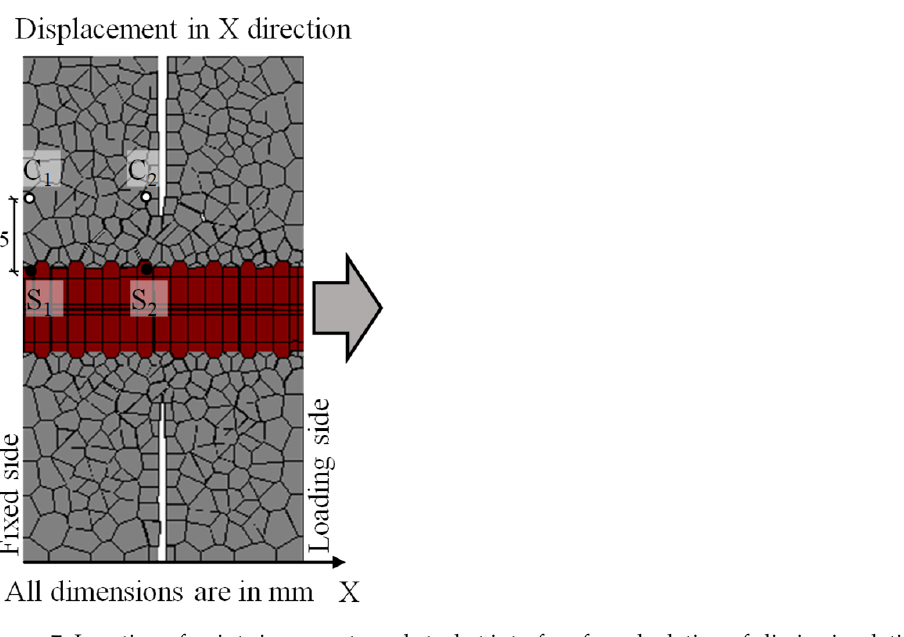
Figure 7. Location of points in concrete and steel at interface for calculation of slip in simulation.